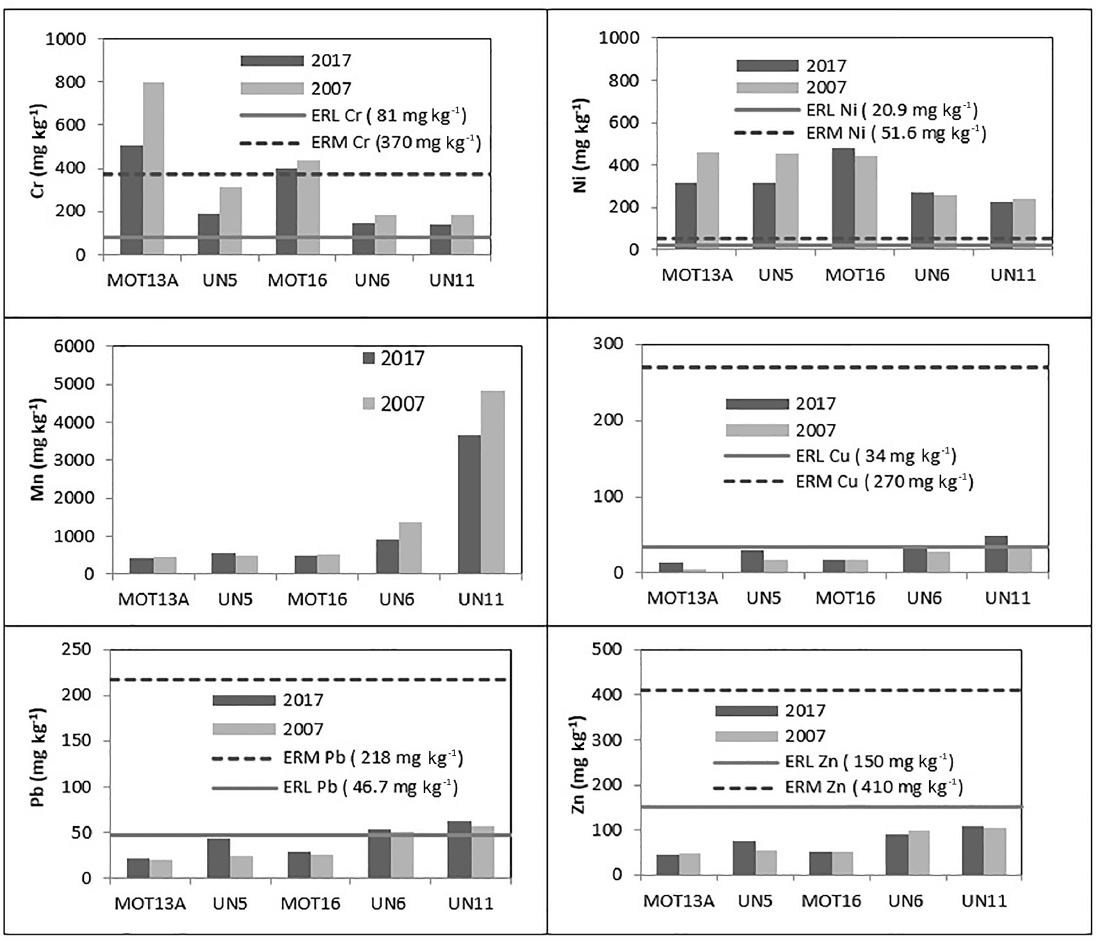
Figure 6. Levels of heavy metals in surface sediments of 2017 and 2007 plotted with sediment quality guidelines. For the coarse sediments of stations MOT13A, MOT16 and UN4, the concentrations of total sediment < 1mm) were